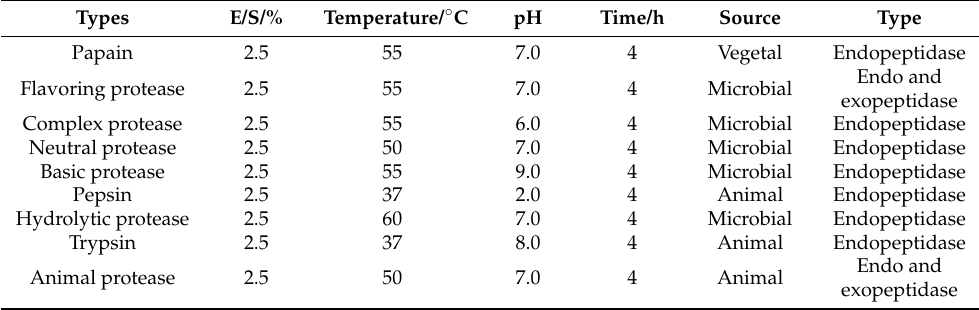
Table 1. Hydrolysis temperature, pH, and time of nine